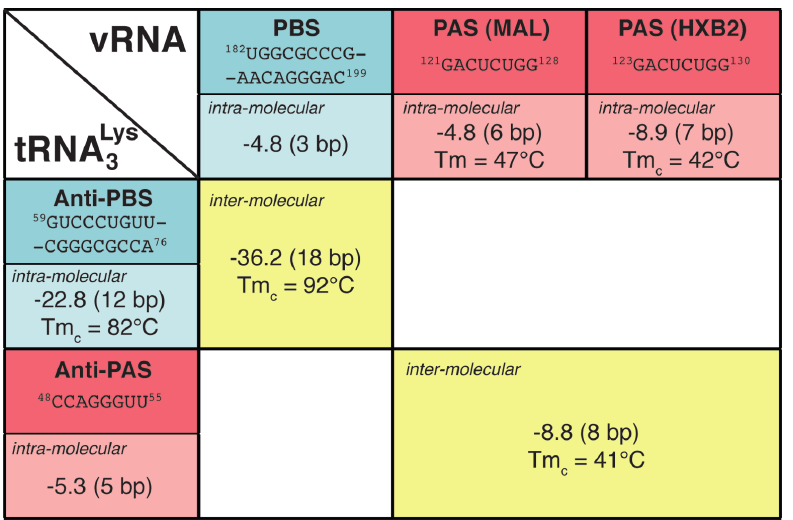
Figure 5. Thermodynamic stability of the interaction involving the PBS (in blue) or the PAS (in red) sequences. D G values calculated with UNAFold [57] are indicated in kcal/mol and the number of base pairs are indicated in parenthesis. The melting temperature Tm c was calculated by UNAFold and the melting temperature Tm was measured by UV spectroscopy (Figure S5). See also Figure S1 for details on the different sequence and secondary structures used to model the intra-molecular interaction within the MAL and HXB2 isolates. doi:10.1371/journal.pone.0064700.g005 tRNA Lys 3 and PAS have been mixed at a 1:1 ratio. It is easily observable on the GU pairs. The free and the bound PAS contain each a GU pair that gives rise to an intense peak appearing at a different chemical shift for the free and the bound PAS (Figure 7C).